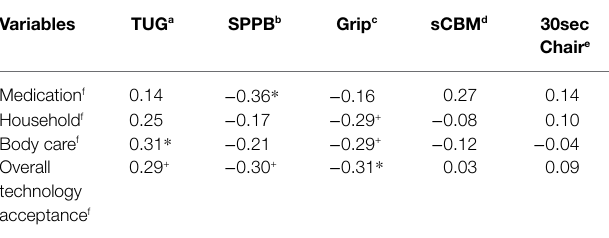
TABLE 3 | Partial correlations of physical performance tests with desired support through assistive technology.